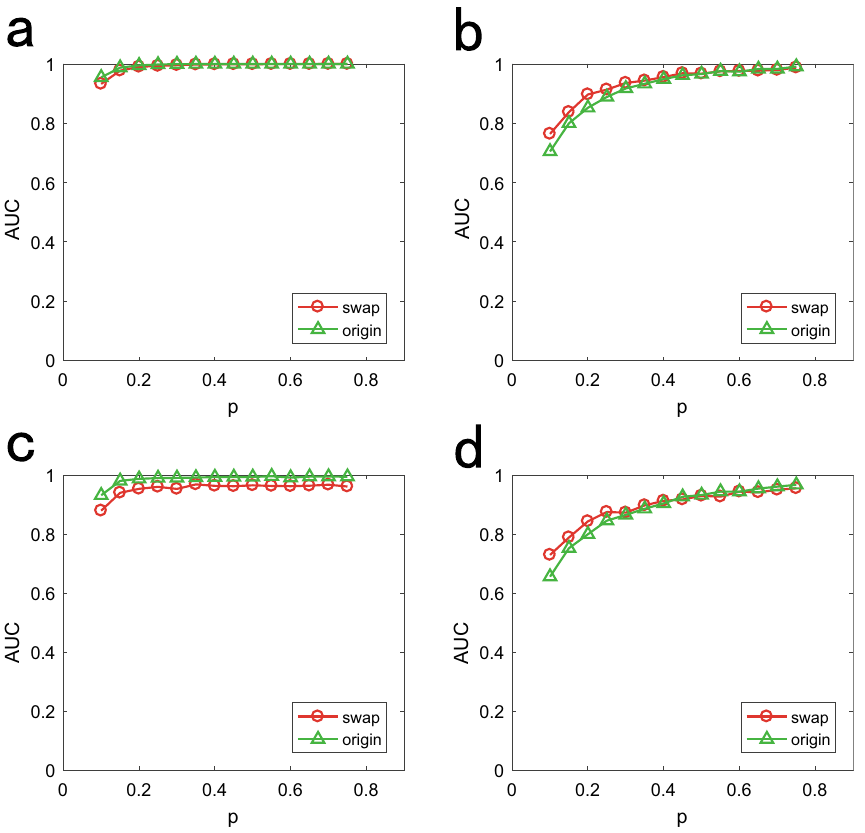
Figure 8. Performance of our algorithm on original network (green) and fully randomly swaped version of it (red). We set the number of sources as 2. ( a ), ( b ) are diffusion and SI dynamics on Football nework respectively. ( c ), ( d ) are diffusion and SI dynamics on Santafe nework